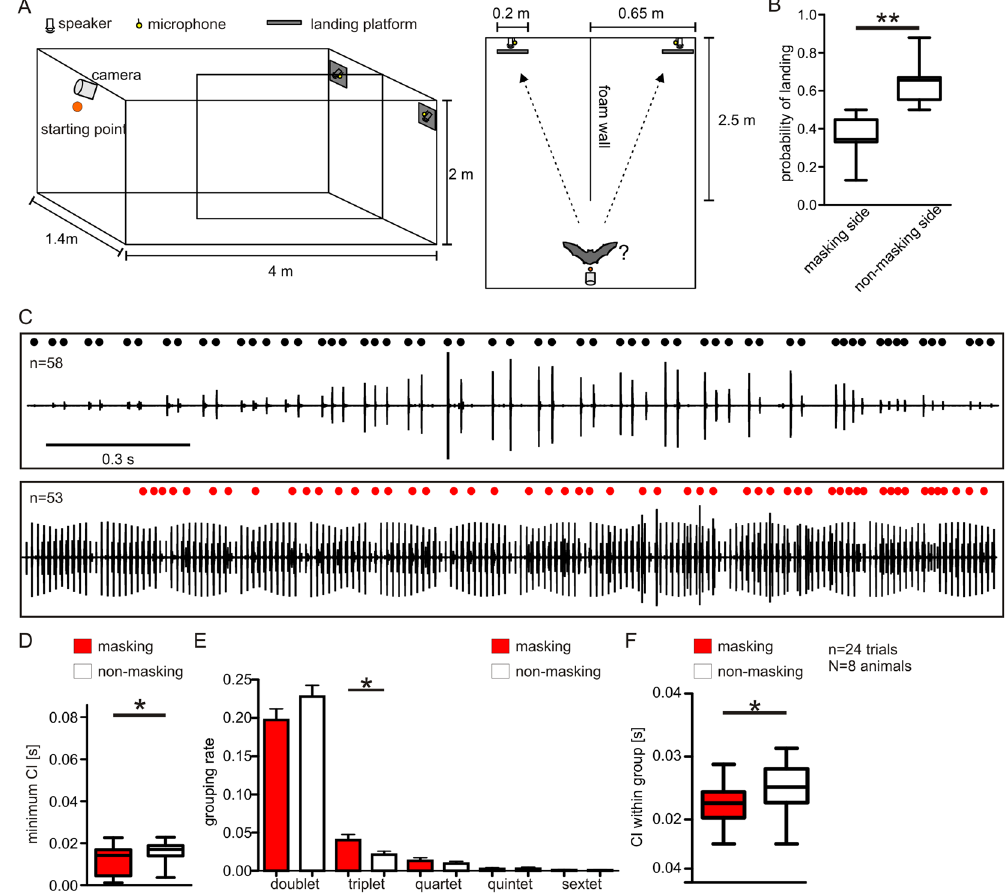
Figure 1. Behavioral adaptations of C. perspicillata when echolocating in noisy areas. ( A ) Schematic lateral (left) and top view (right) of the flight room. ( B ) Boxplots demonstrate the rate of landing on the platform at each side. ( C ) Representative oscillograms illustrate the call patterns of one bat in the absence (top; non- masking condition) and presence (bottom; masking condition) of maskers. Respectively, black and red dots represent time points of call emission during non-masking and masking conditions. n indicates the amount of emitted calls. Note that the lower oscillogram contains the masker in addition to the emitted calls. ( D ) Minimum call intervals (CIs) during masking and non-masking conditions. ( E ) Histogram shows the relative amount of call groups containing two (doublet), three (triplet), four (quartet), five (quintet) and six (sextet) calls in the non-masking and masking condition. ( F ) Boxplots illustrate the CIs within call